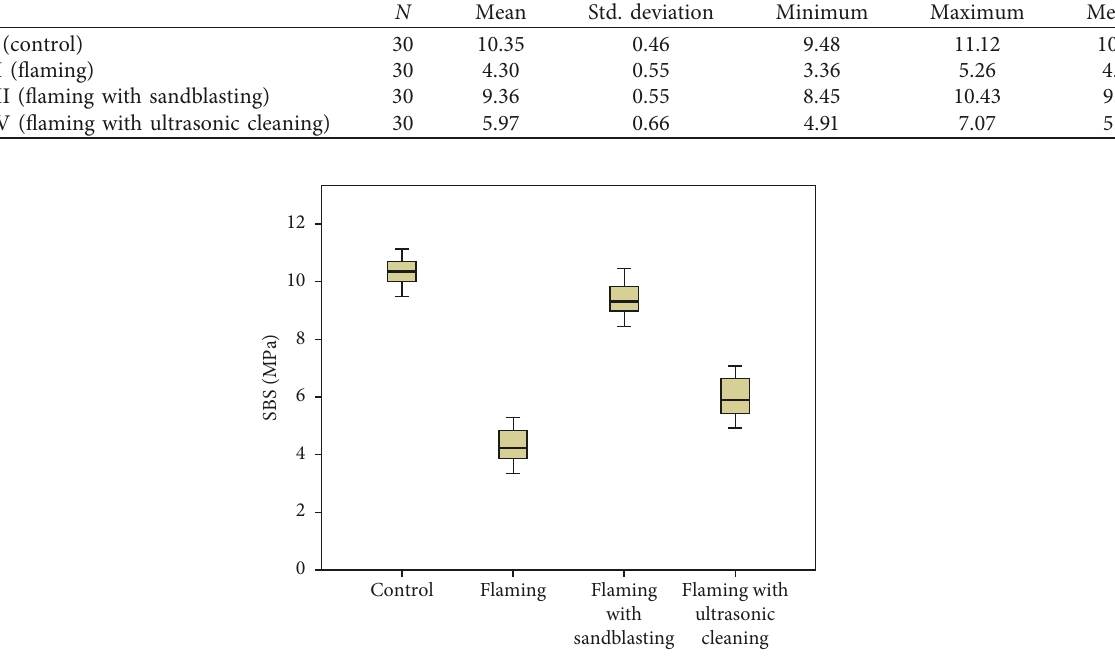
Figure 5: Box plot for mean SBS of different groups. Table 2: Analysis of variance for comparisons of shear bond strength mean values in different groups. Sum of squares